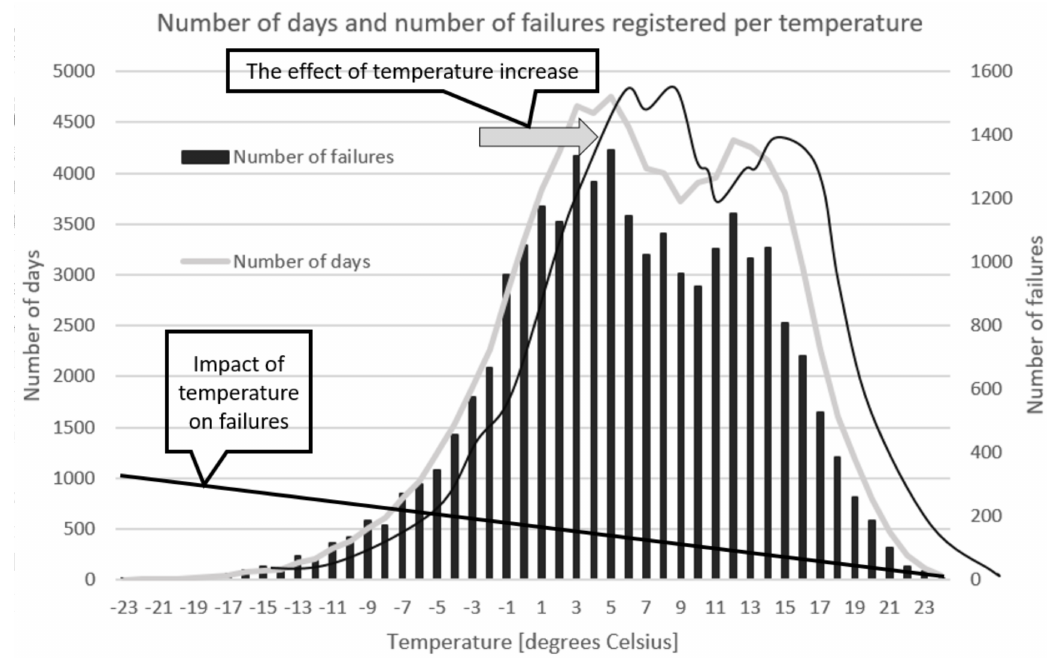
Figure 2. An illustration of data used to predict future impact of temperature increase on